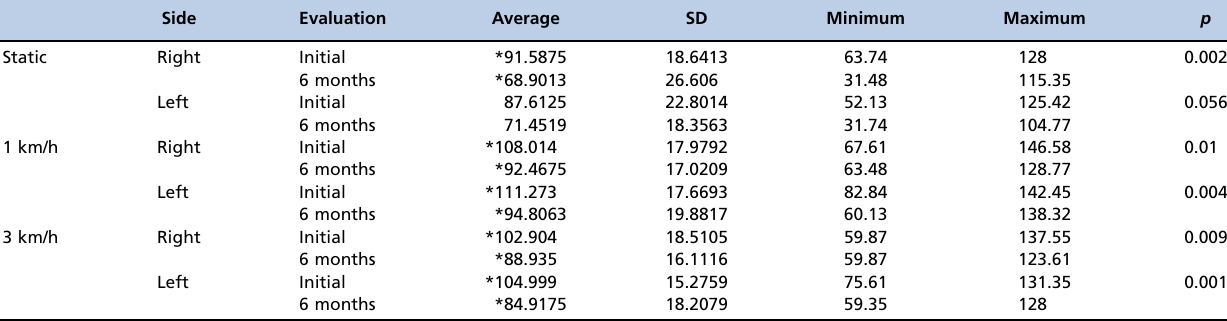
Table 3 - Descriptive statistics for the plantar contact area (cm 2 ) under static and dynamic conditions (1 and 3 km/h) at the initial (initial) and final (six months after bariatric surgery) evaluations of the right and left feet, for the forefeet and rear feet of 16 volunteers.